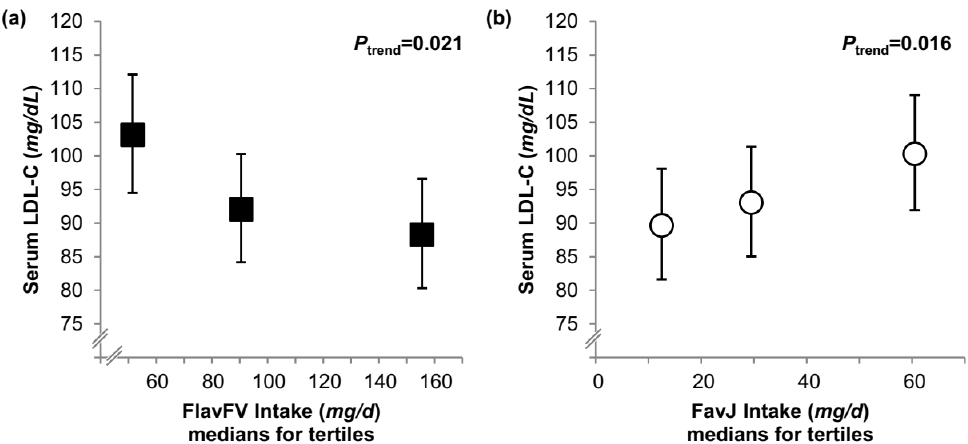
Figure 2. Serum levels of LDL-C in early adulthood by tertiles of dietary flavonoid intake from fruit and vegetables (FlavFV, panel ( a ), ■ ) and flavonoid intake from juices (FlavJ, panel ( b ), ○ ) during adolescence among females ( n = 134). Data are geometric means and 95% CI adjusted for age at blood withdrawal, maternal gestational weight gain, intake of added sugar (residuals on FlavFVJ intake), energy (residuals) and vice versa adjustment for FlavJ ( a ) or FlavFV ( b ) intake during adolescence.